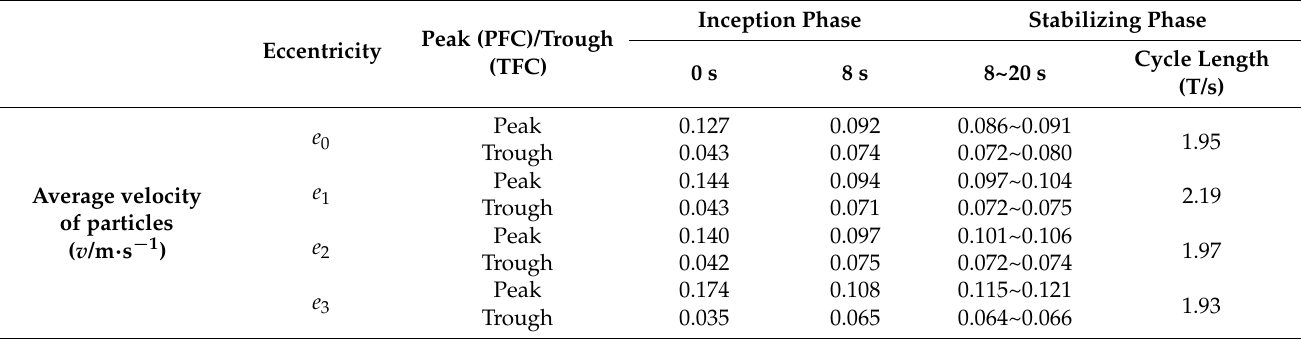
Table 4. The average particle velocity and periodic variation (RP) at 15 rpm.